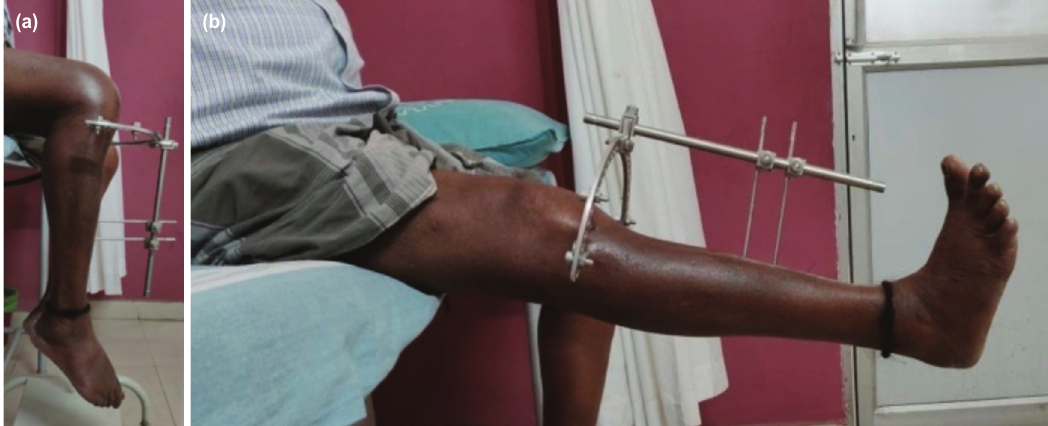
(a) Showing good range of knee flexion. (b) Showing complete extension at the knee Fig. 2: